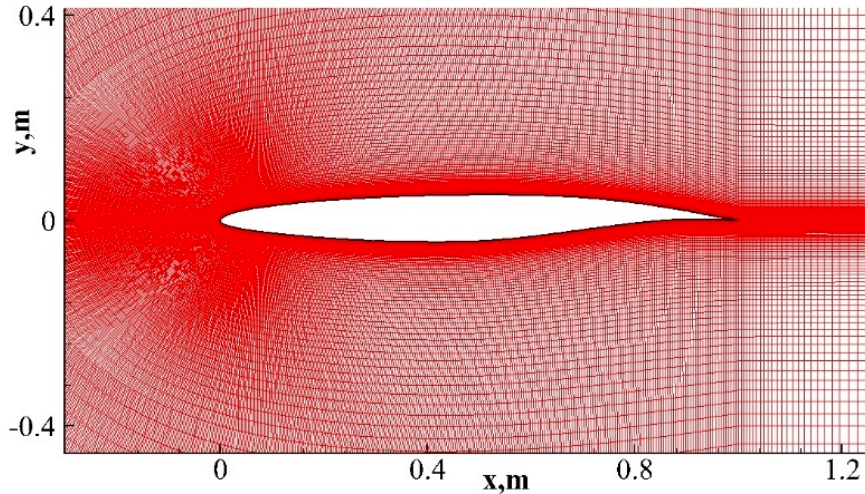
Figure 14. Baseline airfoil grid.